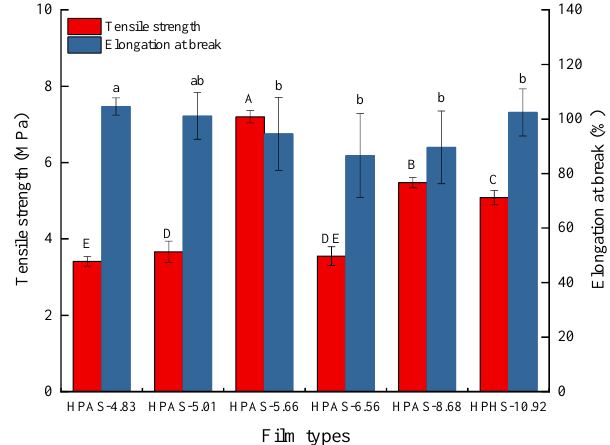
Figure 2. Tensile strength and elongation-at-break of HPAS-CA films with di ff erent citric acid amount. Bars sharing the same letter are not significantly di ff erent ( p < 0.05, same in the other